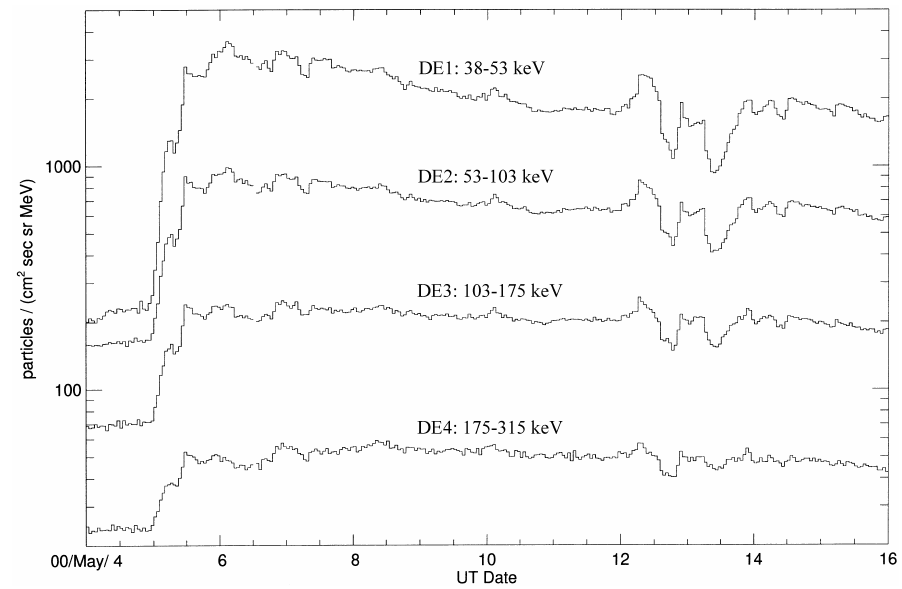
Fig. 1. Overview of 38–315keV hourly-and spin-averaged intensities of magnetically deflected electrons as measured by the WART B detector of the HI-SCALE experiment for the interval 4–16 May 2000, during a major solar flare electron